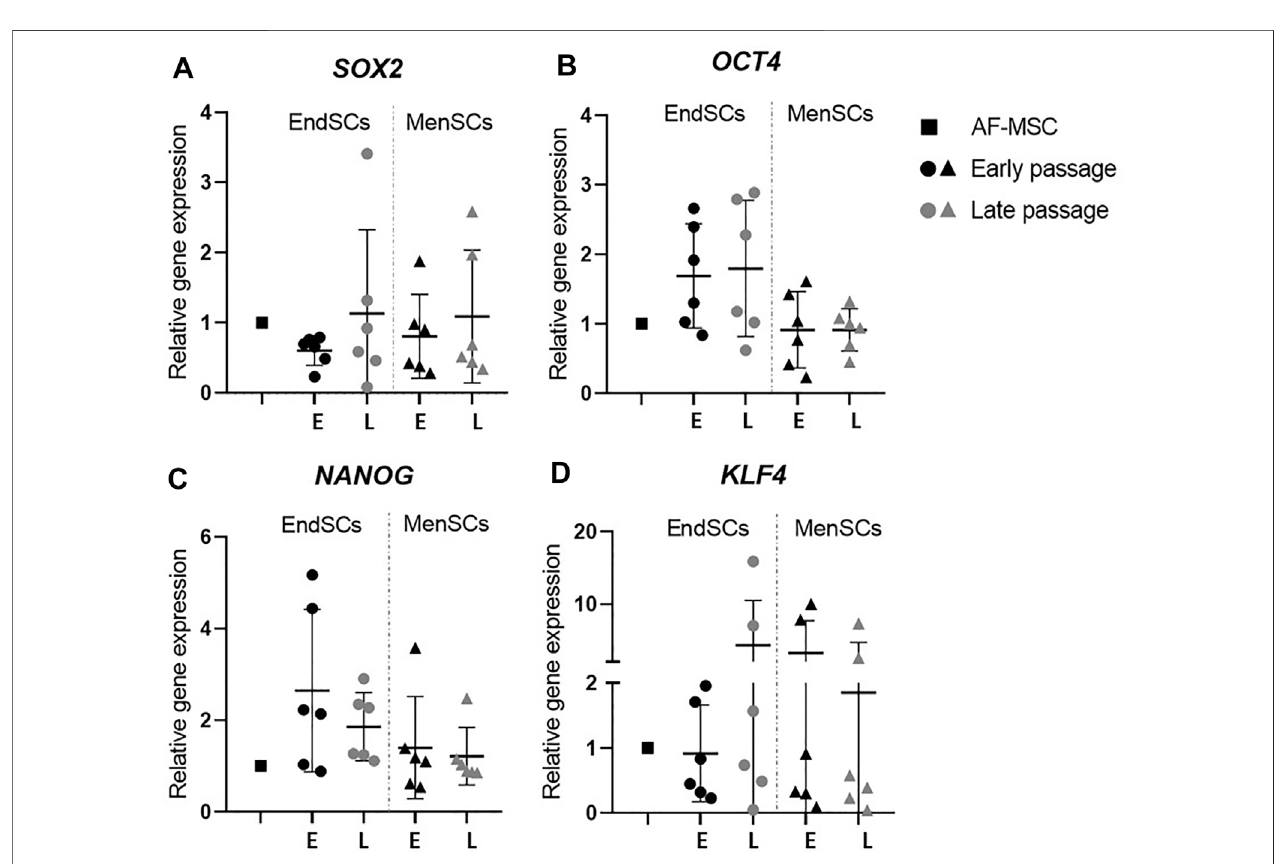
FIGURE 2 | Gene expression analysis of stemness genes in EndSCs and MenSCs. (A,B,C,D) relative gene expression of stem cells pluripotency markers SOX2, OCT4, NANOG and KLF4 was detected in early and late passages and measured using RT-qPCR. E — early passage, L — late passage. Relative gene expression was calculated using ΔΔ Ct method. Data were normalized to GAPDH and presented as mean ± SD ( n (cid:2) 6). No statistically signi fi cant changes were detected between different passages and cell groups as evaluated by one-way ANOVA.